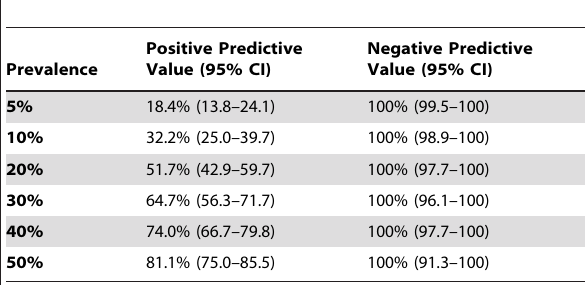
Table 2. Positive and negative predictive values based on variable prevalences of TSH level . 10 m IU/mL.